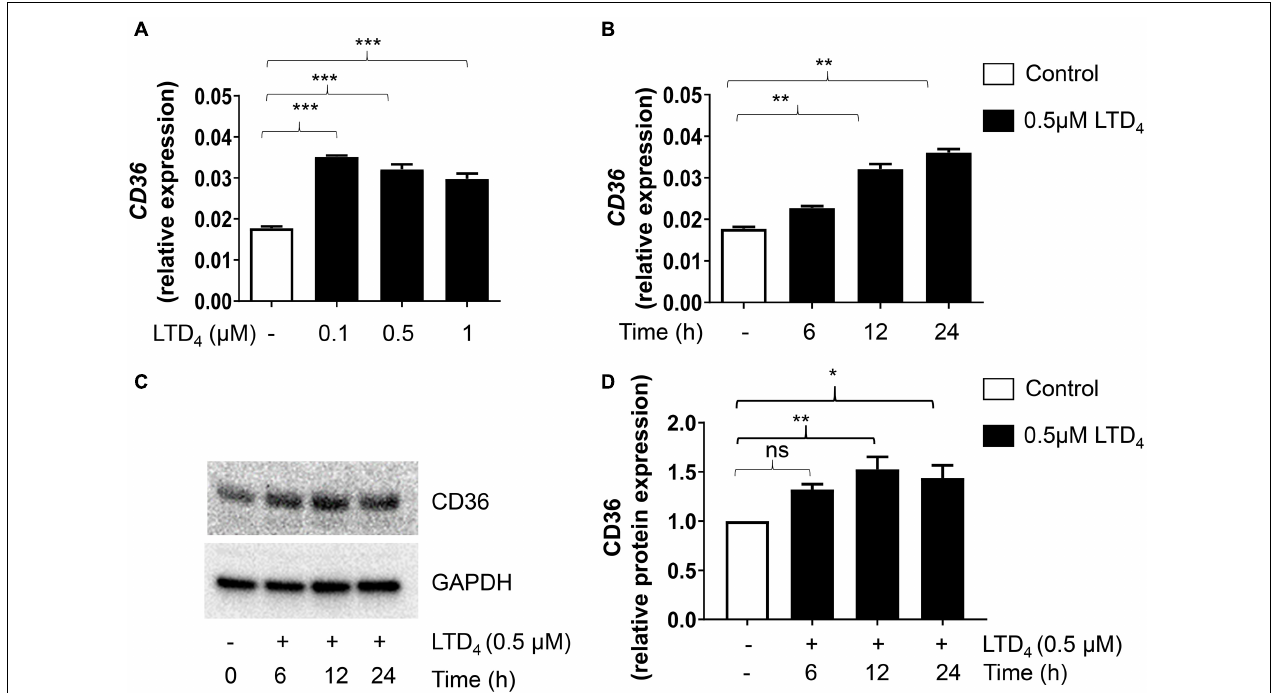
FIGURE 5 | Cys-LTs induce upregulation of CD36 transcript and protein. Raw macrophages were treated with increasing concentrations of LTD 4 for 6, 12, and 24 h, and the expressions of CD36 transcript (A,B) was analyzed using qPCR and protein expression was analyzed by Western blotting (C,D) . The results shown are mean ± SEM from three separate experiments (one-way ANOVA followed by post hoc Tukey multiple comparison test, * p ≤ 0.05, ** p ≤ 0.01, *** p ≤ 0.001, ns = not